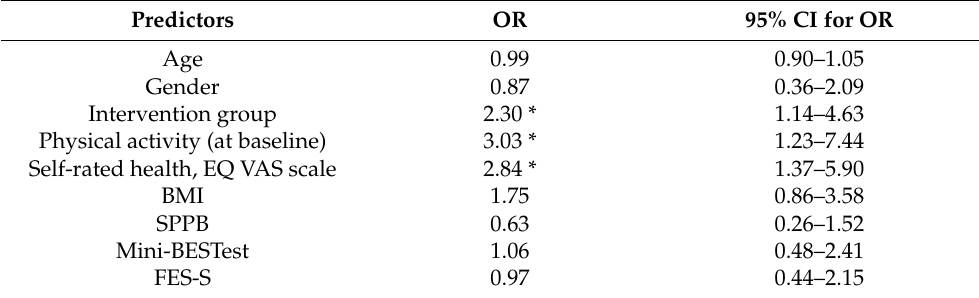
Table 2. First logistic regression model showing independent variables independently associated with the level of physical activity, n = 175.